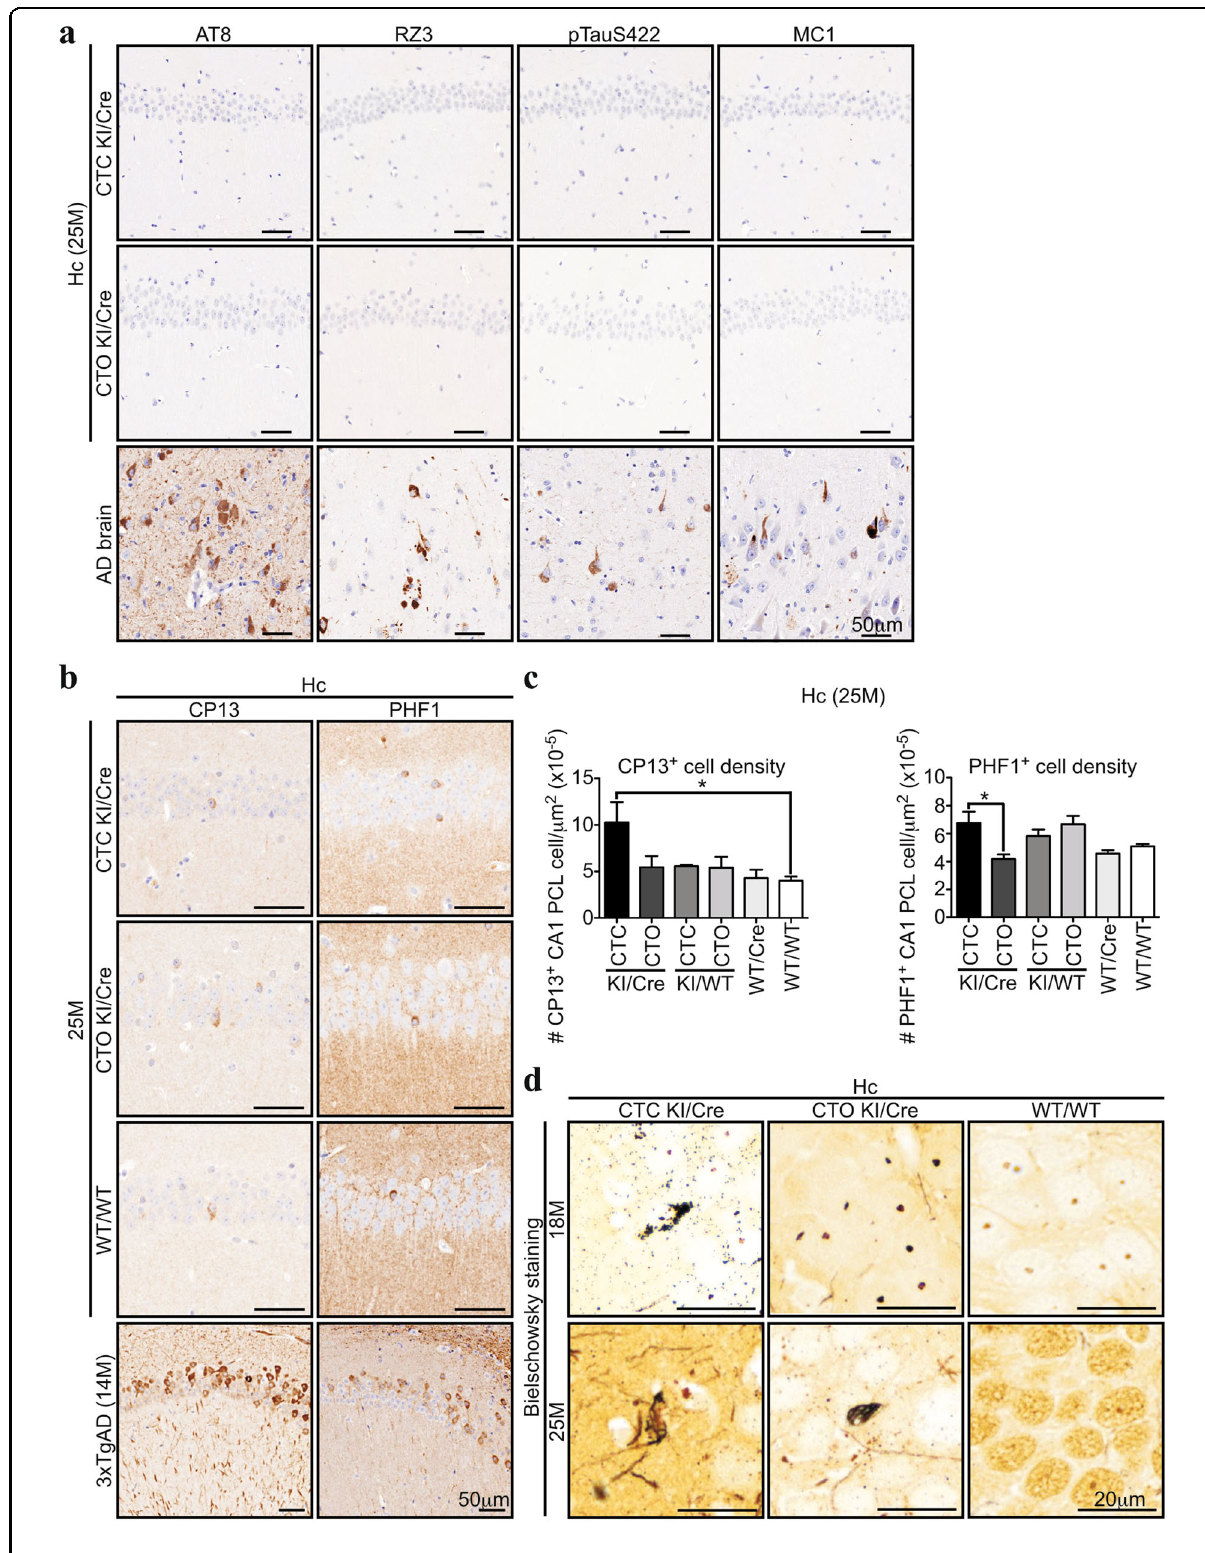
Fig. 6 (See legend on next